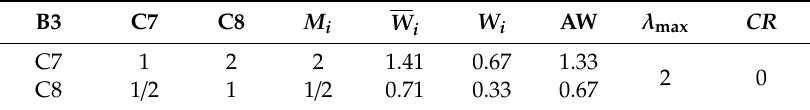
Table 6. Pairwise judgment matrixes of the index layer and their consistency check (evaluation indicators belong to the criterion layer of B3).